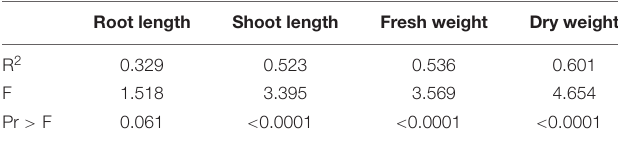
TABLE 11 | ANOVA for morphological parameters. Root